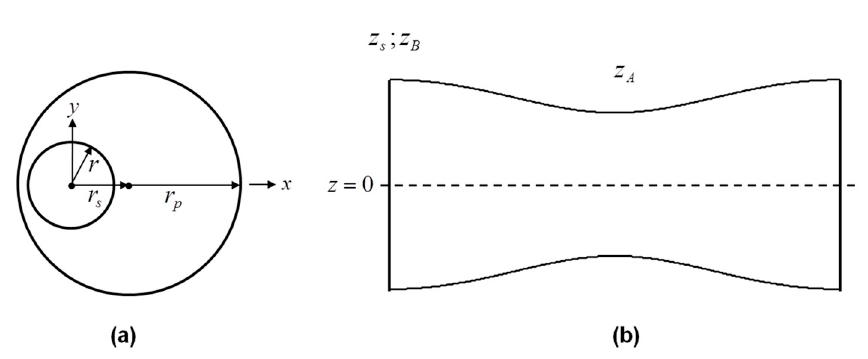
Figure 2. Cylindrical plane inside sphere ( a ) top view of plane at z = 0, ( b ) side view.